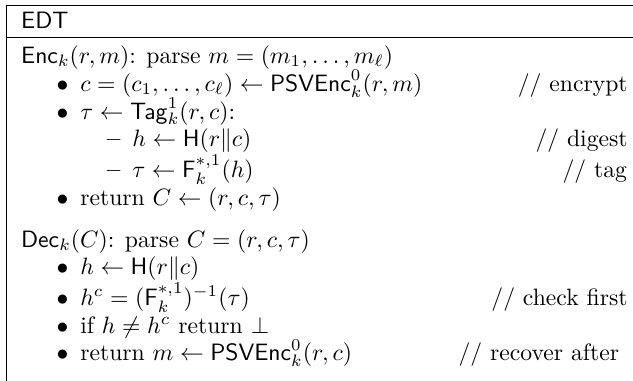
Table 7: EDT leakage-resilient authenticated